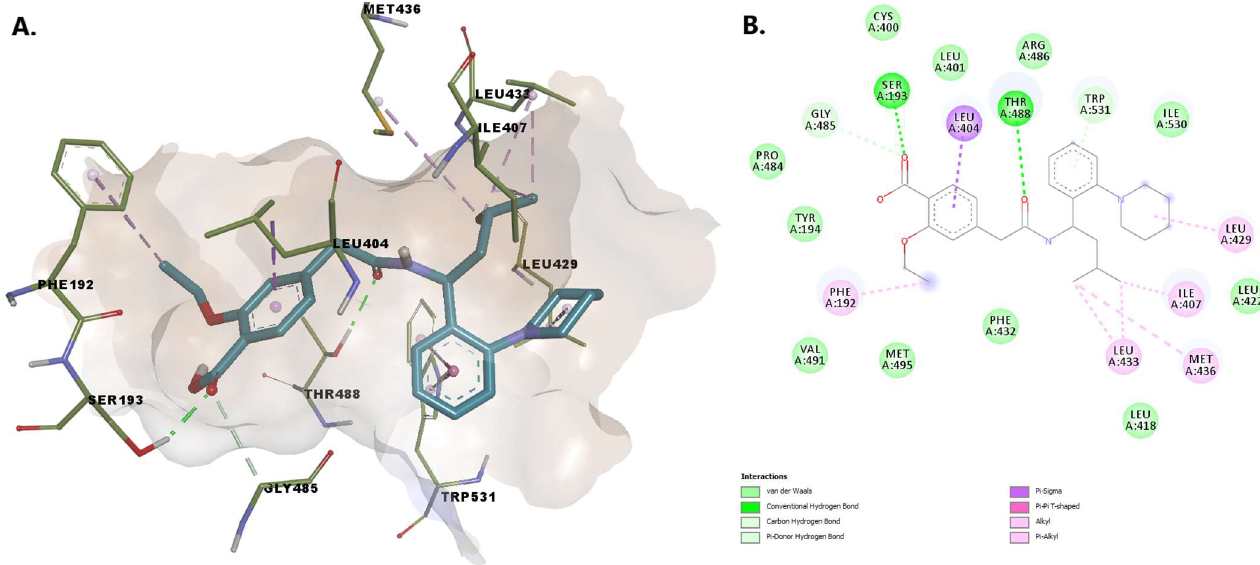
Figure 6. ( A ) 3D binding conformation of repaglinide into FAAH binding site; ( B ) 2D diagram of protein-ligand interactions between FAAH and repaglinide.